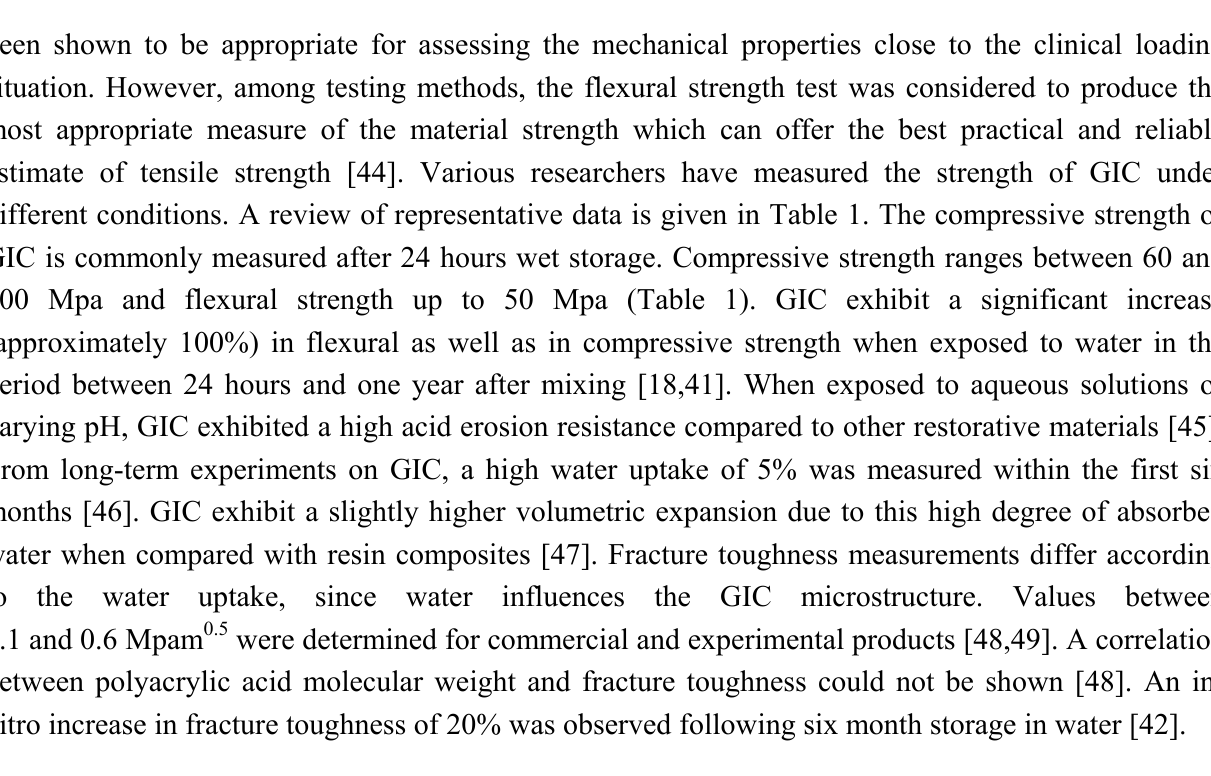
Table 1. Flexural and compressive strength of conventional